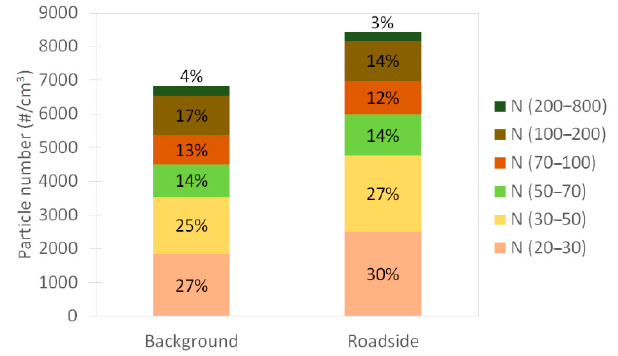
Figure 4. Relative particle-size contribution at both sites over the measurement period. Size-resolved and normalized particle-size distribution on the two study sites are shown in Figure 5. Both sites presented the same profile with a bimodal size-resolved particle distribution. Nevertheless, the normalized distribution showed an “unimodal” distribution with the start of one mode. The two figures highlighted a similar distribution between the two sites, but showed again the higher levels of particles smaller than 100 nm at the roadside site compared to the background